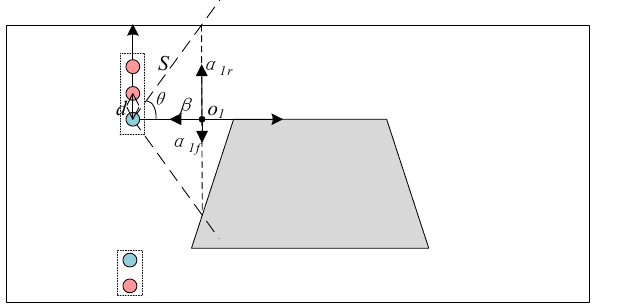
Figure 10. The impact of road boundaries on the UGVs fleet after moving away from the obstacle.